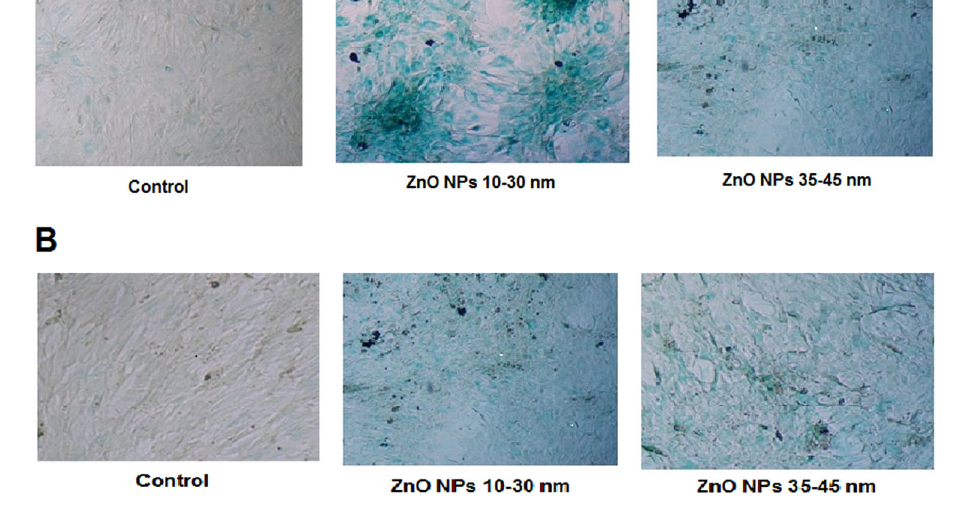
Fig. 6 Relative gene expression of Nanog gene in the cells treated with ~10 – 30 and 35 – 45 of ZnO NPs in comparison to the control groups. The expression level of the Nanog gene in both AMSCs ( A ) and BMSCs ( B ) was signi fi cantly downregulated with 10 – 30 and ~35 – 45 nm ZnO NPs ( P ≤ 0.001 and P ≤ 0.01, respectively). The